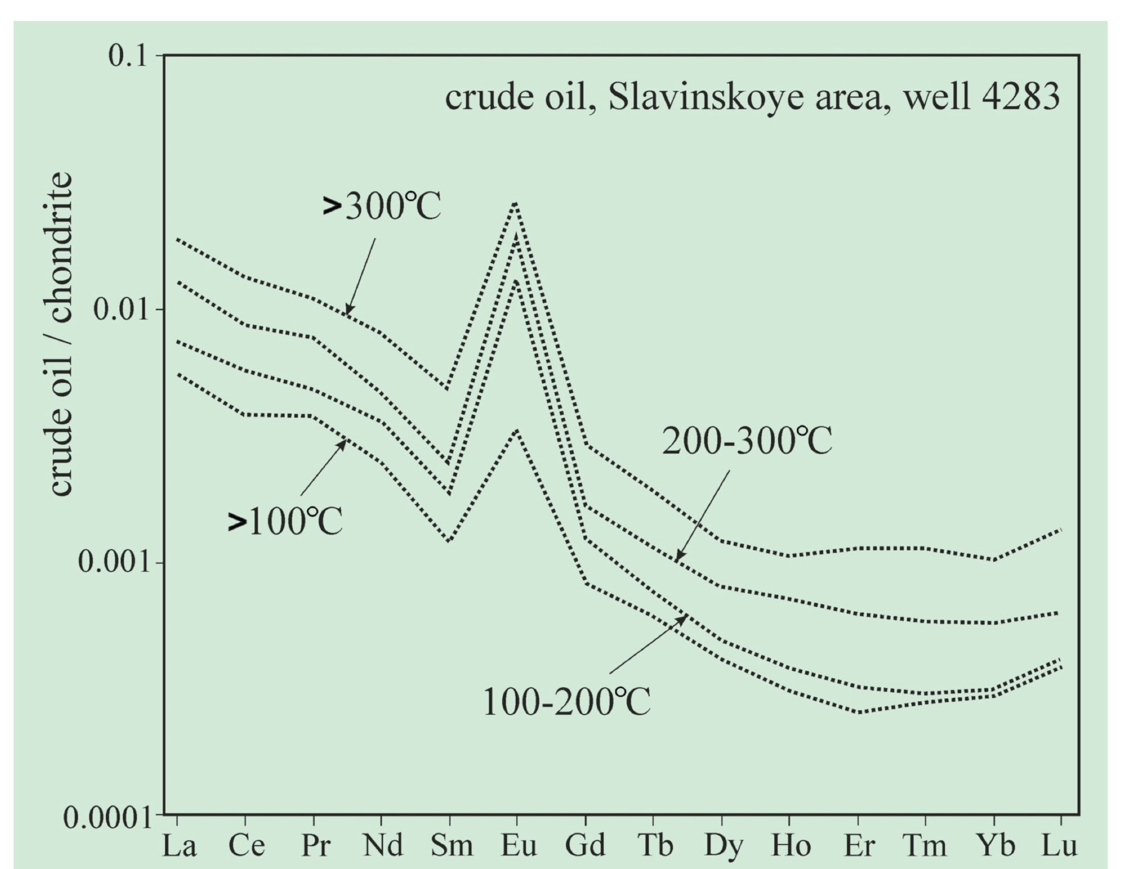
Figure 3. Distribution curves of rare earth elements normalized to chondrite [16] for crude oil of Slavinskoye oil field of Shaimsky petroleum district. The temperatures are corresponding to the crude oil’s distillation